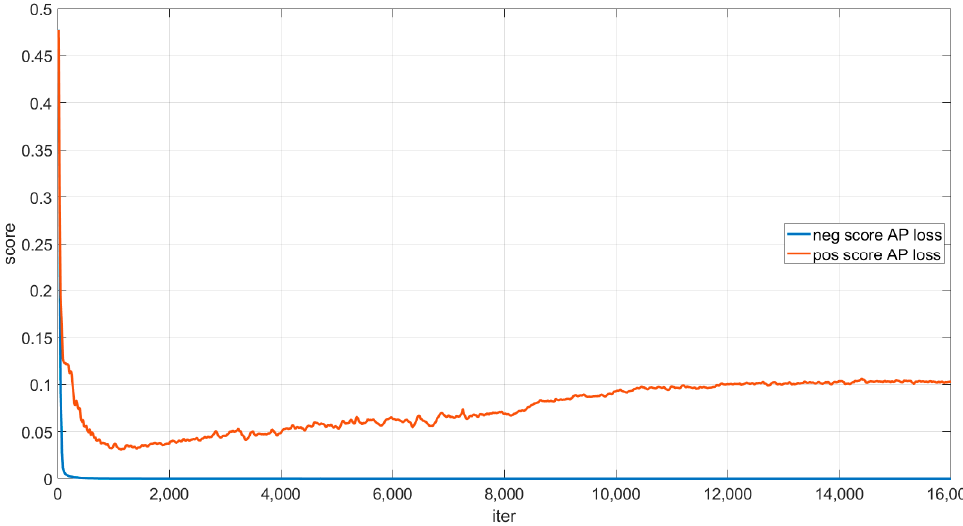
Figure 5. Curves of the average classification scores of positive and negative samples output from the network trained by AP loss during the training phase.